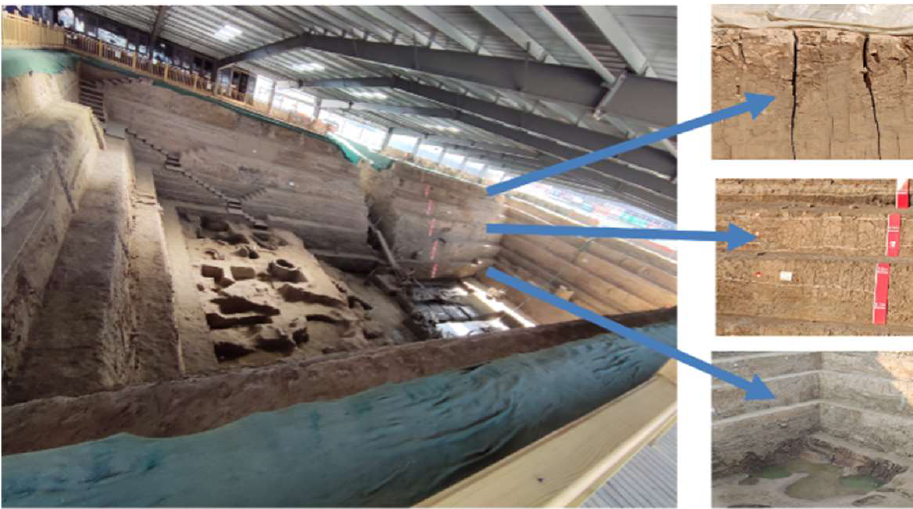
Figure 1. Shrinkage and deterioration of the Zhouqiao site in Kaifeng.